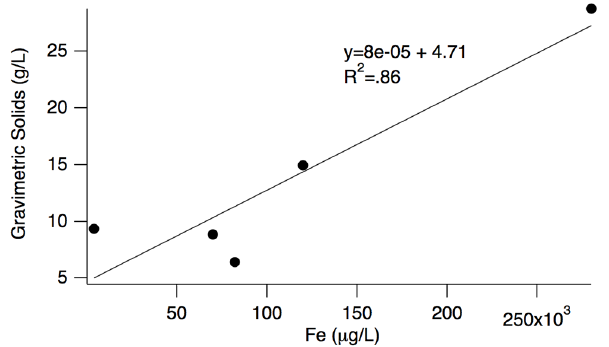
Figure 3. Fe (µgL − 1 ) vs. gravimetric solids (gL − 1 ) from five sam- ples collected at Mera